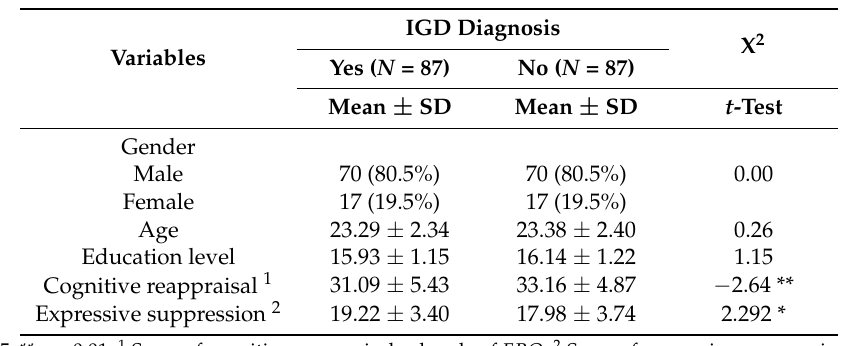
Table 1. Age, educational level, emotional regulation, hostility, depression, and severity for the IGD and control groups.